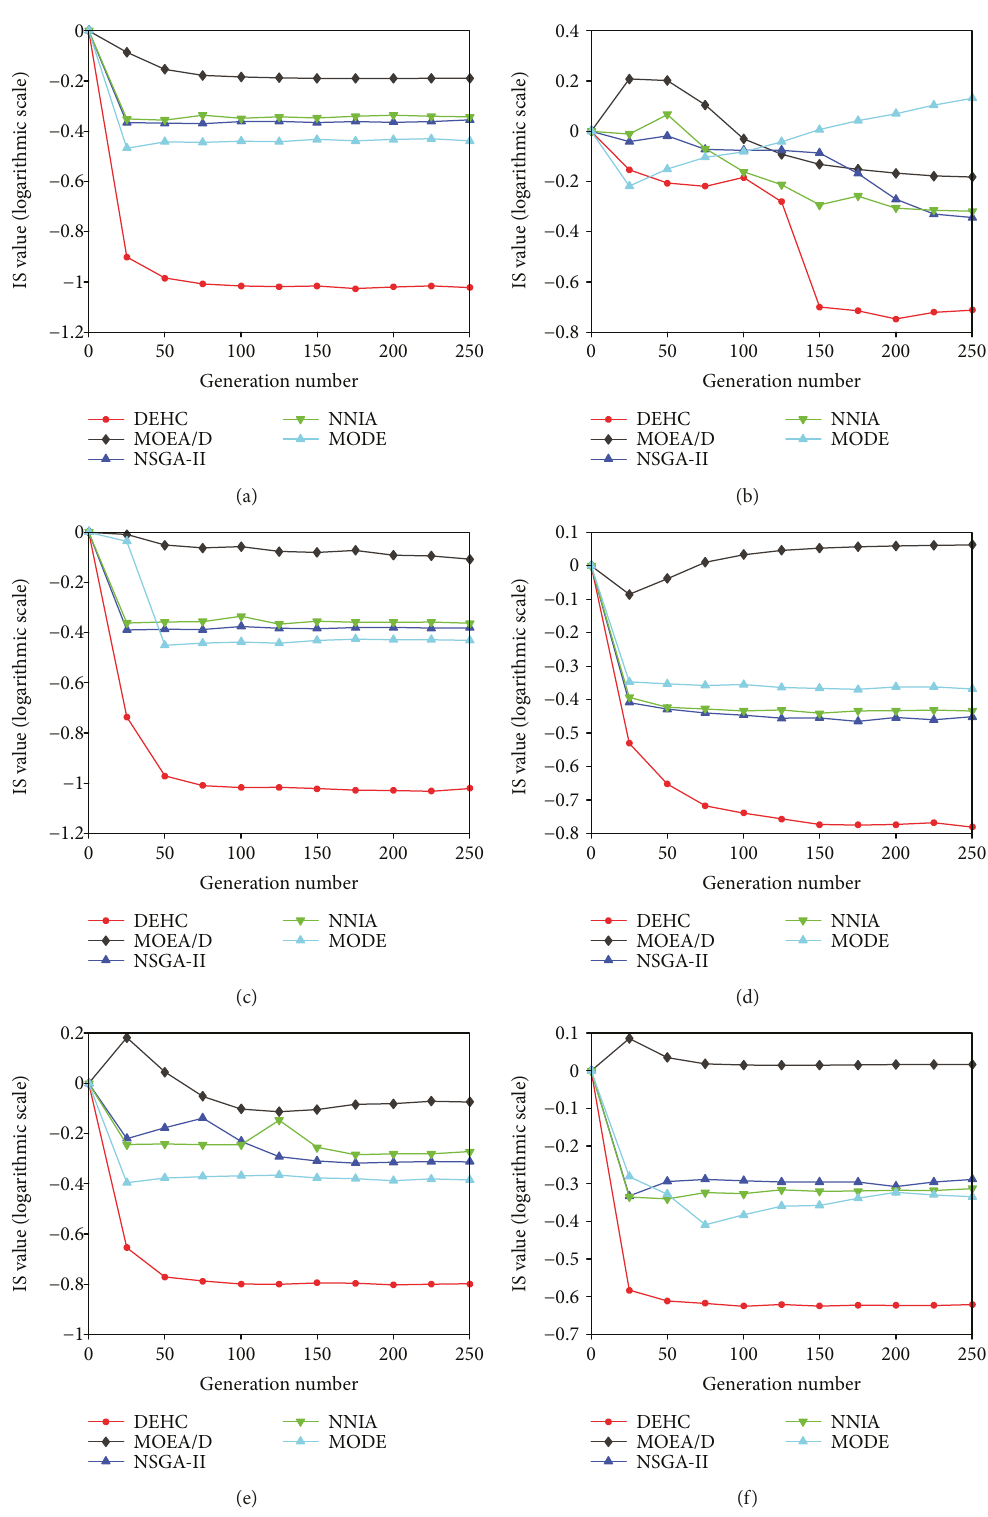
Figure 7: Median IS values versus the evolution time. (a) DTLZ2, (b) DTLZ3, (c) DTLZ4, (d) DTLZ5, (e) DTLZ6, and (f)